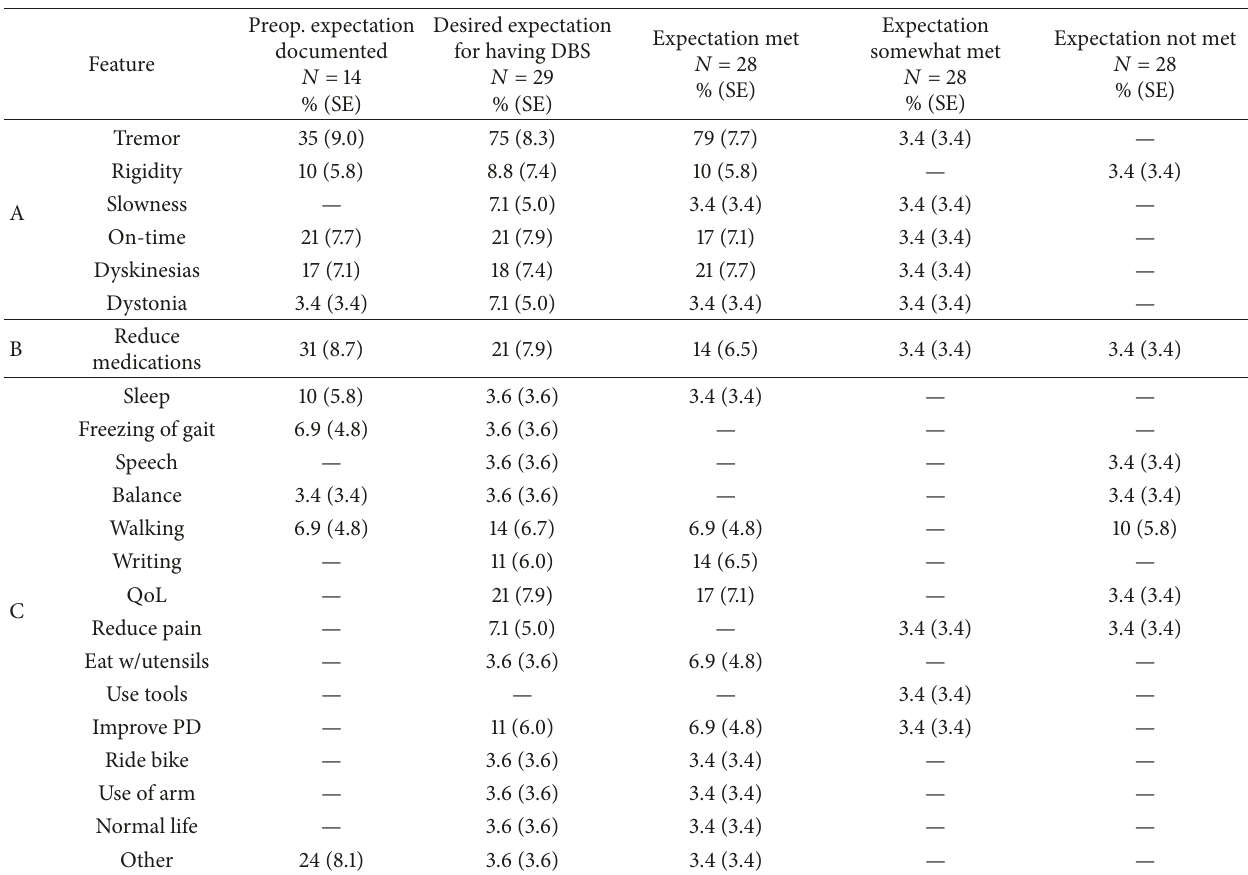
Table 3: A comparison of pre- and postoperative patient expectations from DBS surgery. Expectations listed under “A” are deemed realistic expectations with good chances for improvement following DBS surgery. Reducing PD medications (“B”) following DBS surgery is a realistic expectation depending on the target for electrode placement. Symptoms listed under “C” may or may not improve following DBS